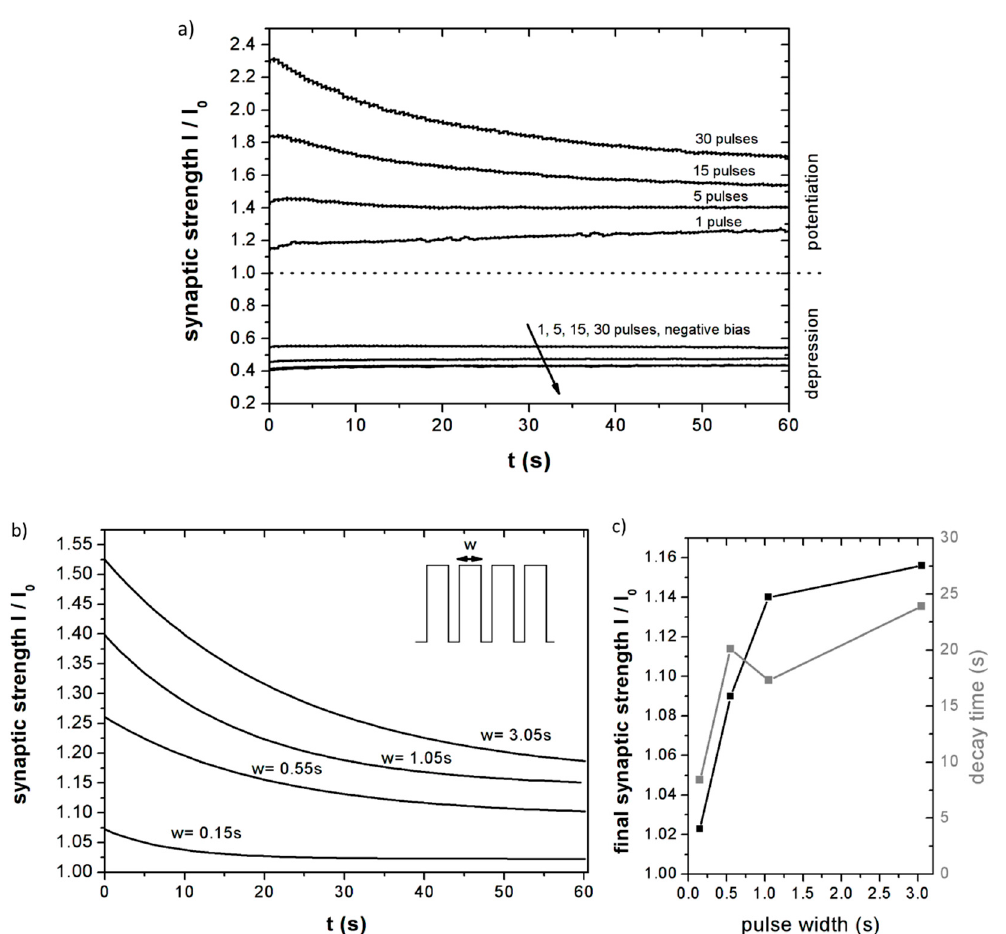
Figure 3. ( a ) Relative current across a LaCPSi memristor after stimulation with an increasing number of potentiation pulses. Current at a 2 V bias of a LaCPSi memristor once the stimuli has ceased. The current value is normalized to the value before stimulation, thus representing the ‘synaptic strength’ of the ‘synapse’. Stimulus consisted of di ff erent number of 10 V pulses of either polarity. ( b ) Dependence of synaptic strength as a function of pulse duration. Synaptic strength of a LaCPSi memristors at 0.5 V bias after stimulation with 10 potentiation pulses of 10 V of increasing width. Pulse separation was 50 ms. ( c ) Dependency of the final synaptic strength and decay time of LaCPSi memristors with potentiation pulse